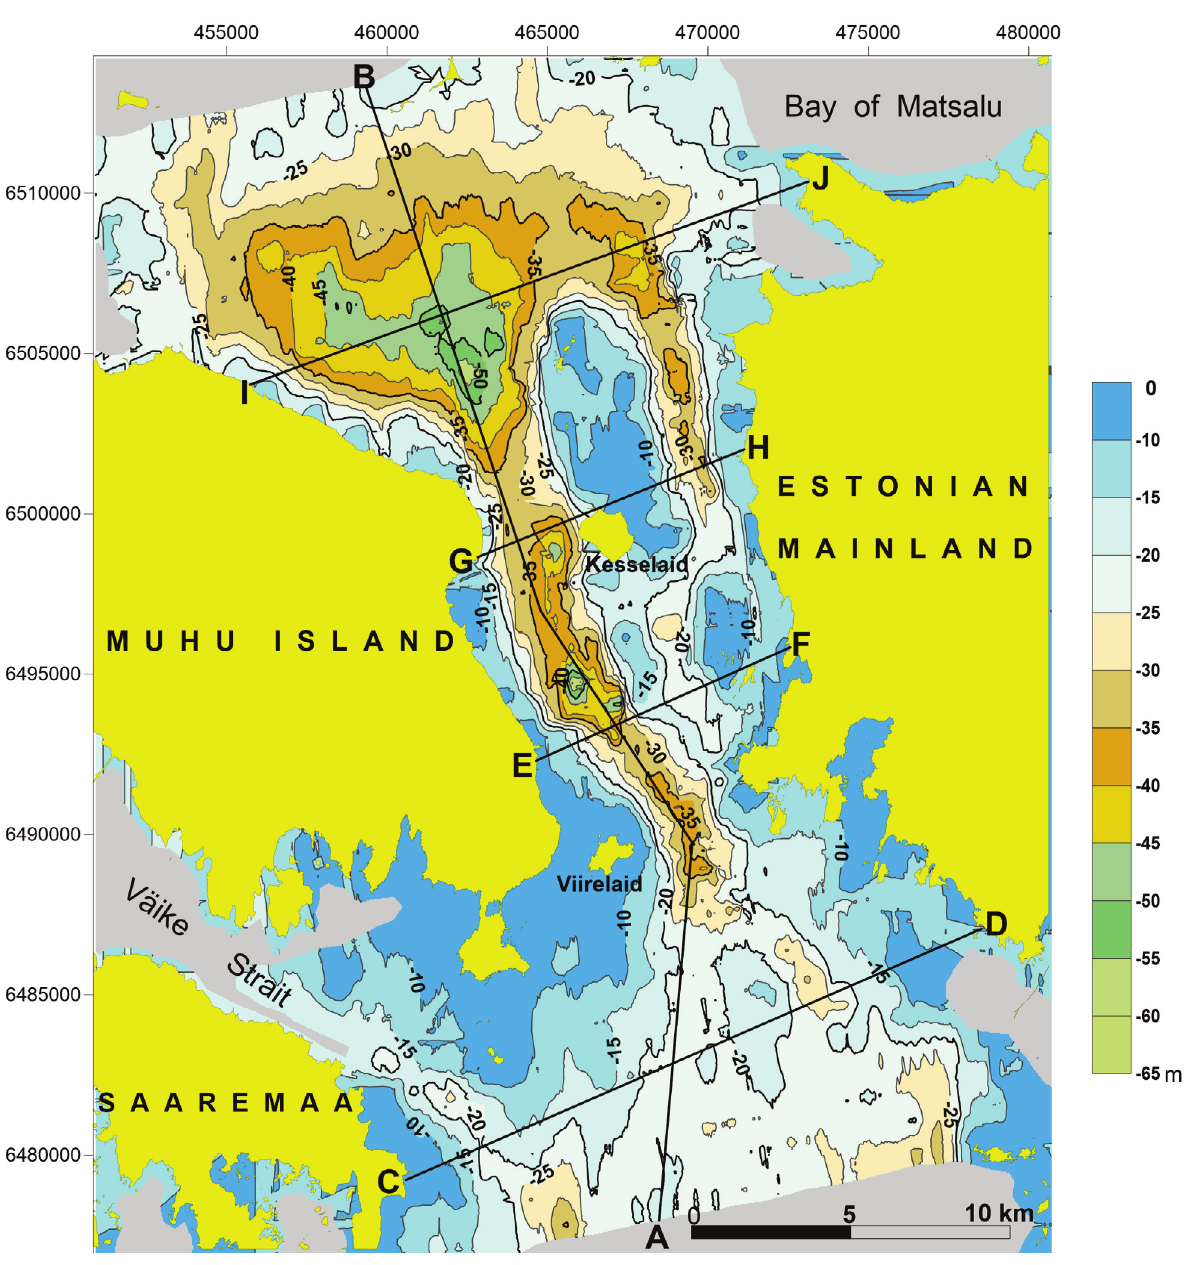
Fig. 4 . Bedrock relief map of the study area with lines of the cross-sections shown in Fig.